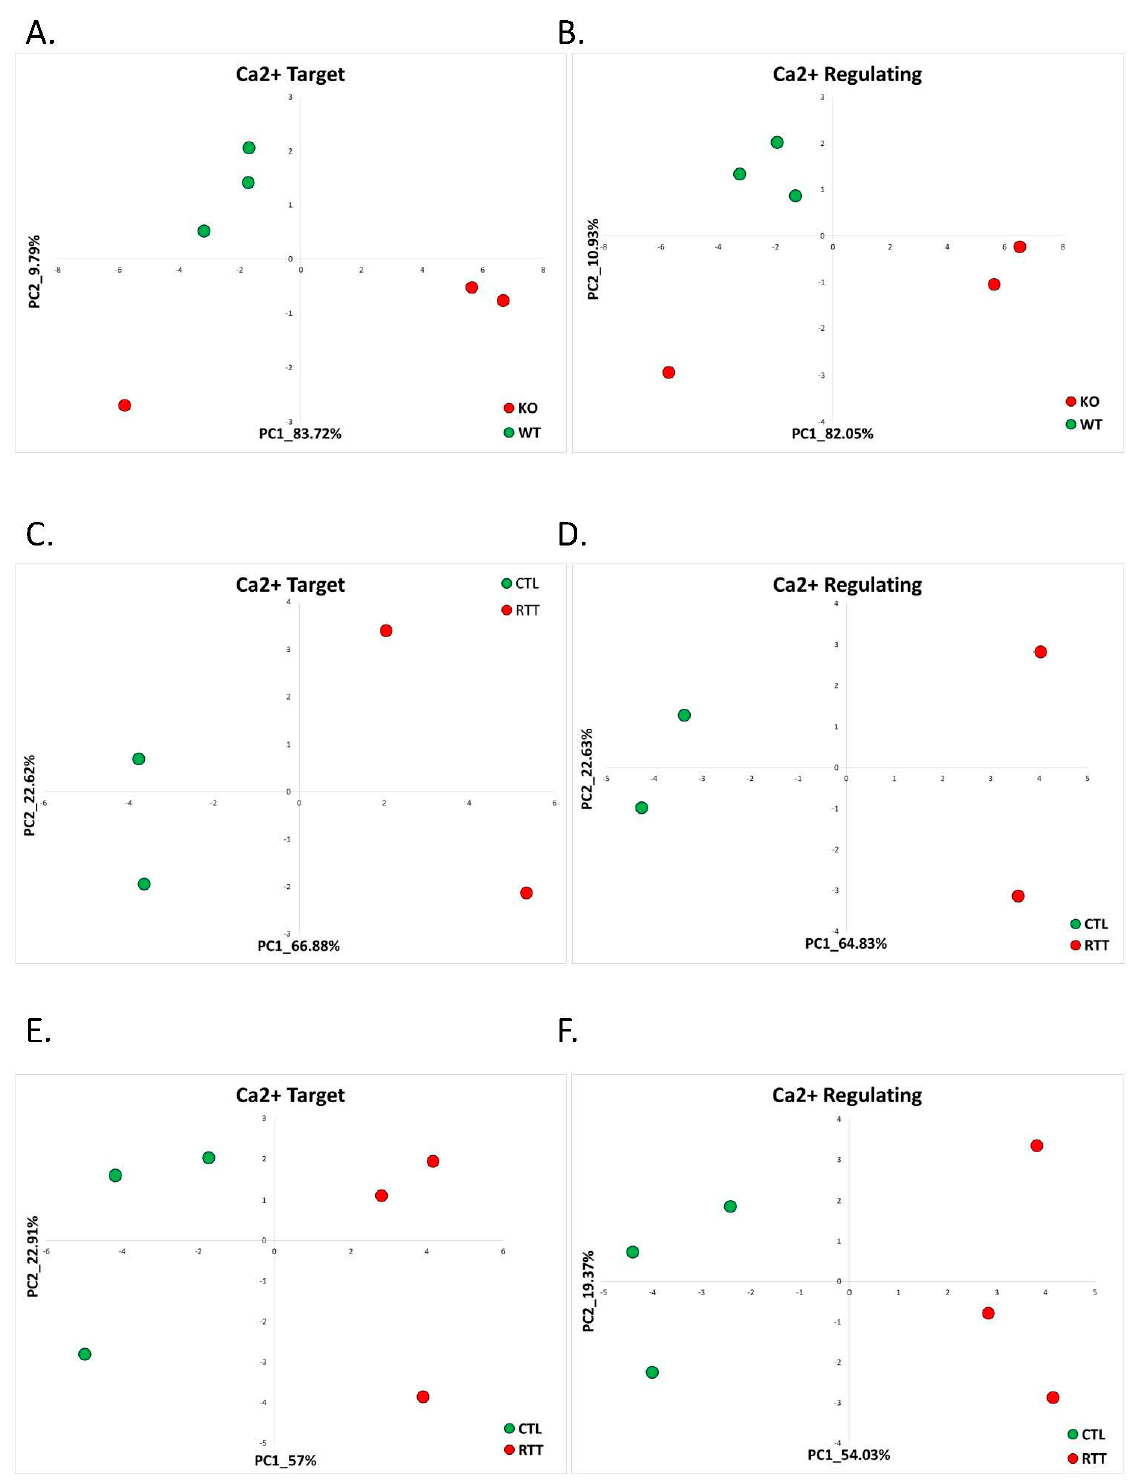
Figure 2. Rett Syndrome: ca-target and ca-regulating signatures. ( A ) PCA based on the expression of calcium-target signature genes in cerebellum of Mecp2-KO and WT mice. The WT samples are denoted in green, while the Mecp2-KO samples are in red. ( B ) PCA based on the expression of calcium-regulating signature genes in cerebellum of Mecp2-KO and WT mice. The WT samples are denoted in green, while the Mecp2-KO samples are in red. ( C ) PCA based on the expression of calcium-target signature genes in postmortem cingulate cortex of Rett patients and healthy controls. The control samples are denoted in green, while the Rett samples are in red. ( D ) PCA based on the expression of calcium-regulating signature genes in the postmortem cingulate cortex of Rett patients and healthy controls. The control samples are denoted in